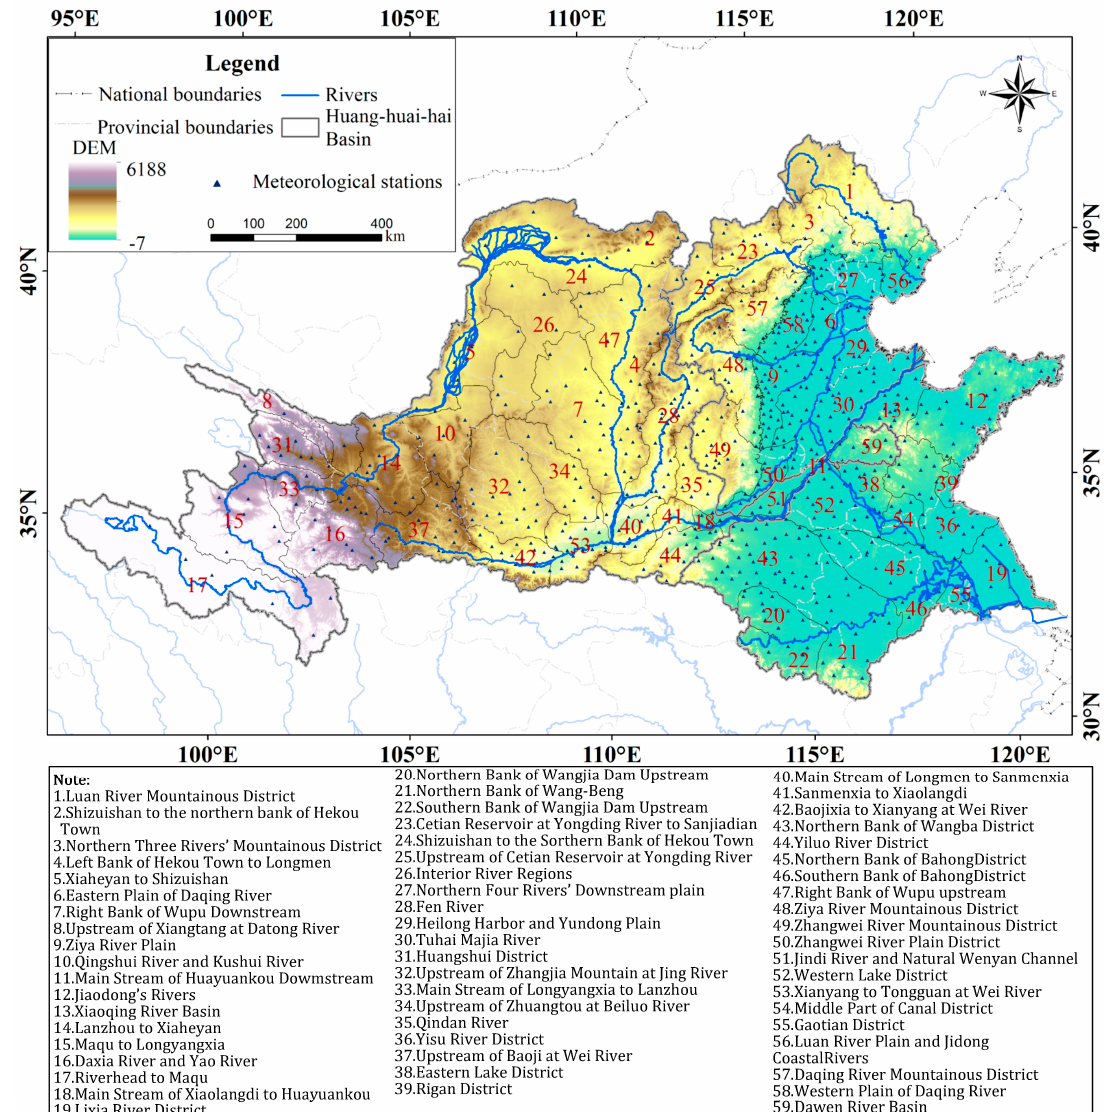
Figure 2. Meteorological stations and three-level water resources districts in the Huang-Huai-Hai River Basin.